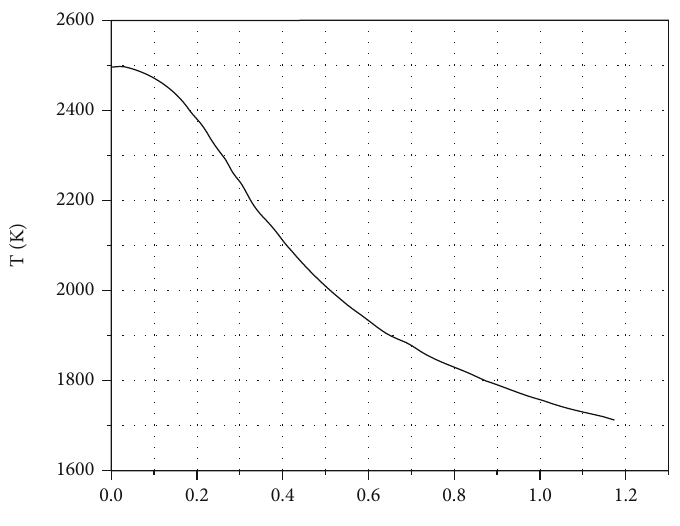
Figure 10: Temperature curve of the gunpowder combustion gas.